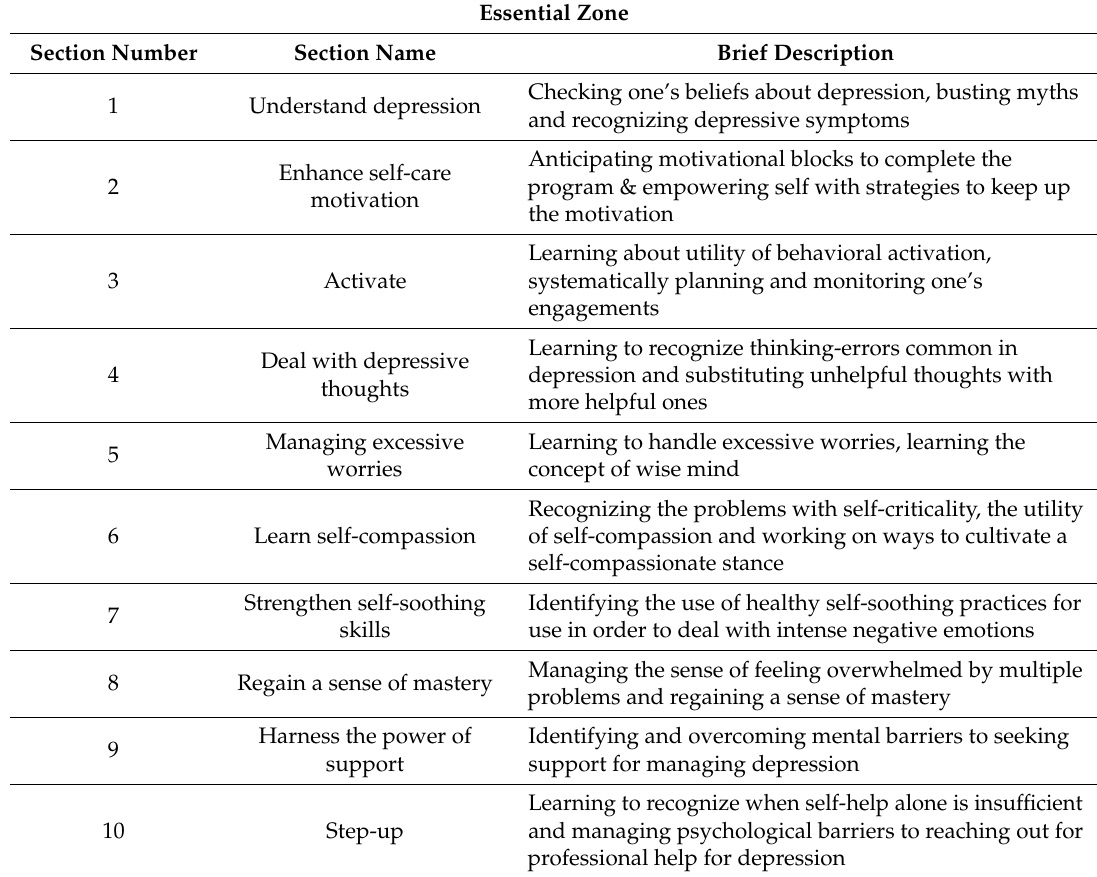
Table 1. Content of